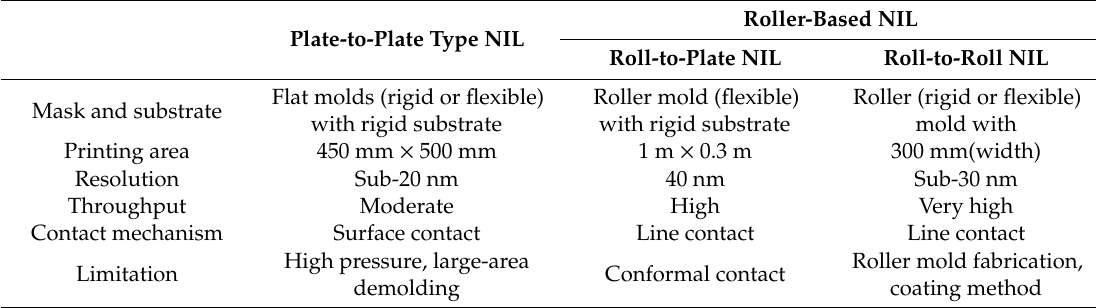
Table 2. Comparison of the various types of roller-based